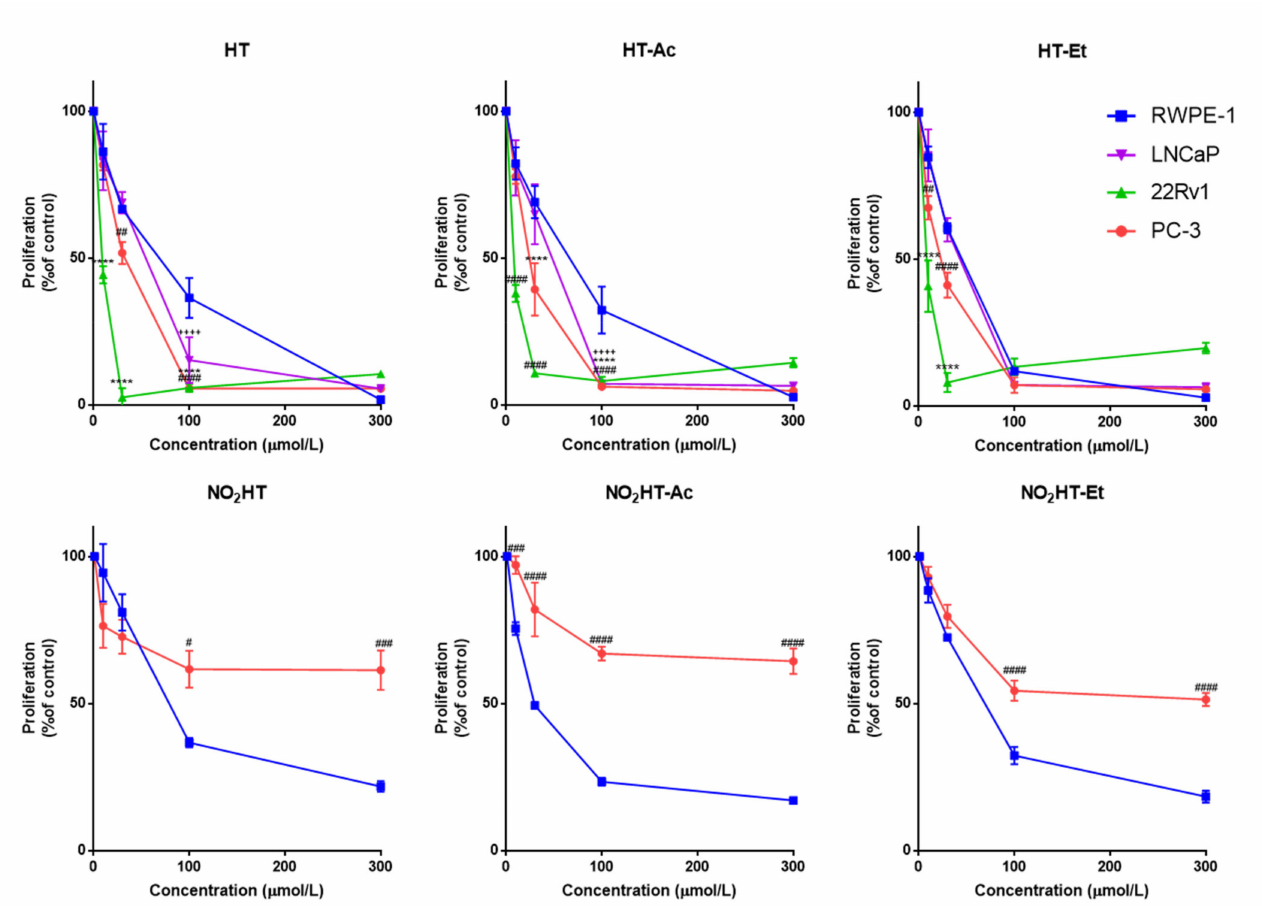
Figure 2. Concentration-response curves on cell proliferation of HT and derivatives (48 h treatment) in normal RWPE-1, and in cancer LNCaP, 22Rv1, and PC-3 cell lines. Data are expressed as percent of control proliferation (set at 100%) and represent the mean ± SEM (4 experiments) vs. each compound concentration ( µ mol/L). Symbols ( + LNCaP, * 22Rv1, # PC-3) indicate statistically significant differences with the corresponding RWPE-1 value: ++++ p < 0.0001, * p < 0.05, ** p < 0.01, *** p < 0.001, **** p < 0.0001, ## p < 0.01, ### p < 0.001, #### p < 0.0001. Abbreviations: HT, Hydroxytyrosol; HT-Ac, hydroxytyrosyl acetate; HT-Et, ethyl hydroxytyrosyl ether; NO 2 HT, nitrohydroxytyrosol; NO 2 HT-Ac, nitrohydroxytyrosyl acetate; NO 2 HT-Et, ethyl nitrohydroxytyrosyl